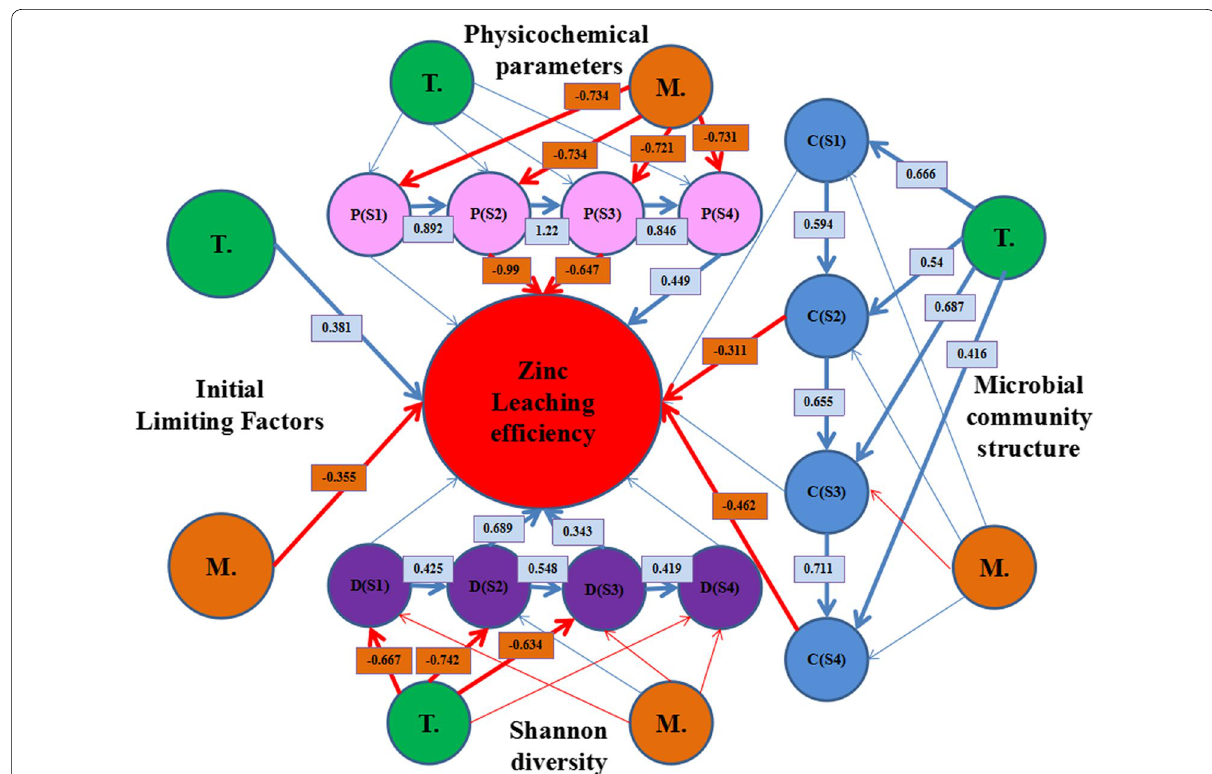
Fig. 5 The direct and indirect effects of temperature and the original mineral composition on zinc leaching efficiency. The effects of temperature, mineral composition and physicochemical parameters (model 1)/microbial community structure (model 2)/microbial diversity (model 3) on zinc leaching efficiency, explored with Partial Least Squares Path Modeling (PLS-PM). Mineral composition and microbial community structure were represented by the top two axes (DCA1 and DCA2) of DCA. The whole physicochemical parameters was represent by the values of PC1 and PC2 (the top two axes) of PCA. The blue line represented the positive correlation, and the red line represented the negative correlation. The bold line showed the relation was significant (p < 0.05) or marginally significant (p < 0.1) and the regular line showed the relation was no significant. Models were assessed using goodness of fit (GoF) statistic. The GoFs for model 1–3 were 0.642, 0.599 and 0.642,